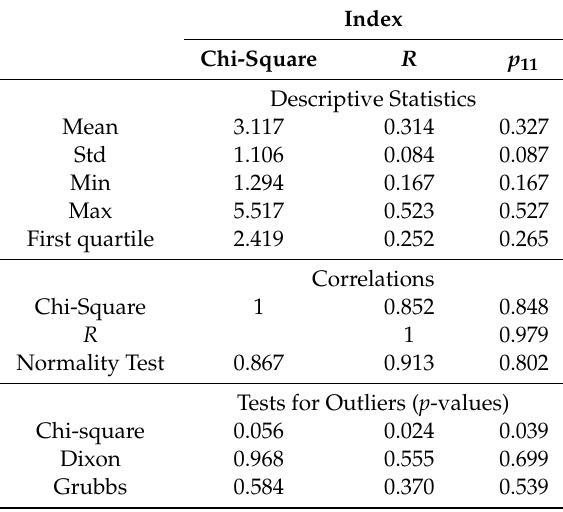
Table 3. Descriptive statistics and tests for outliers for the chi-square, R , and p 11